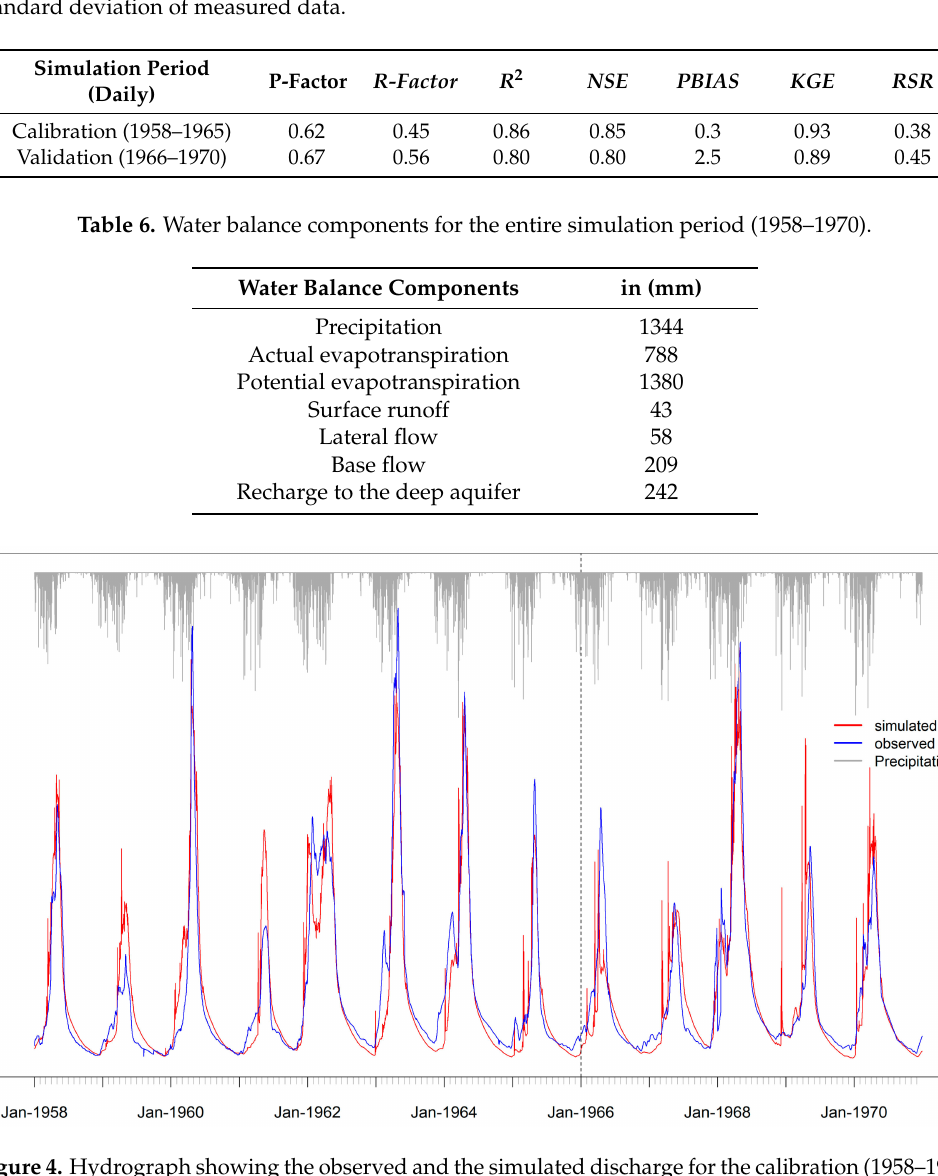
Table 5. Summary of the quantitative model performance analysis for the calibration and validation period. P-factor is the percentage of measured data covered by the 95PPU uncertainty band, R-factor is the relative width of the 95PPU uncertainty band, R 2 is the coefficient of determination, NSE is the Nash–Sutcliffe efficiency, PBIAS is the percent bias, KGE is the Kling–Gupta efficiency, and RSR the standard deviation of measured data.